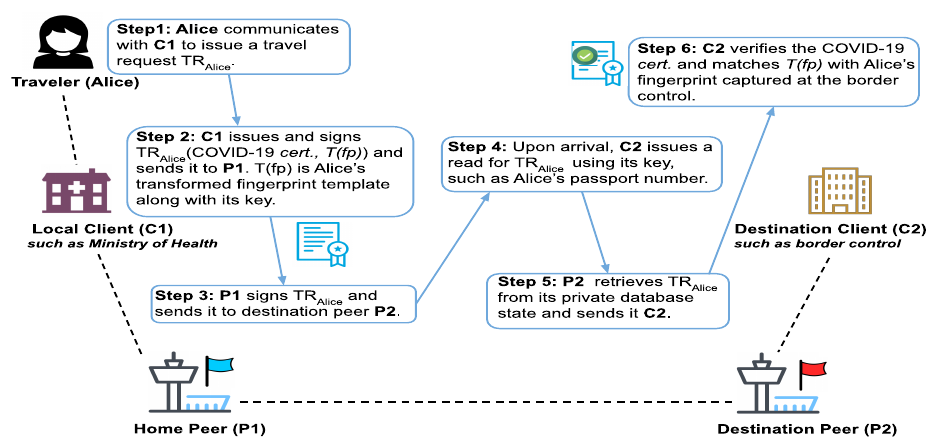
Figure 3. Issuing and Verifying COVID-19